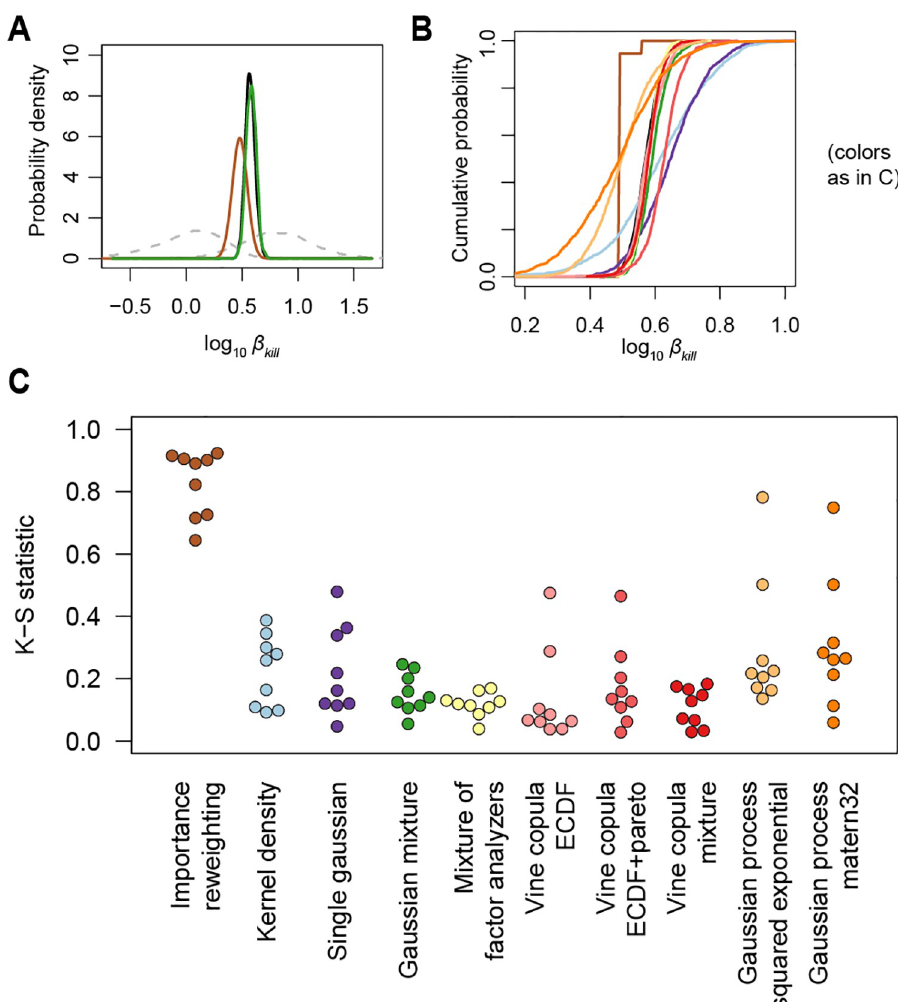
Fig 6. Sequential inference performance. (A) Marginal density of one of the parameters (for clarity, only the GM approximation and importance reweighting result is shown). The dashed lines indicate the posterior of the two datasets separately, and the black line is the true joint. Other colors are the same as in C. (B) Empirical cumulative distribution of the same parameter, showing all approximation methods. The colors are the same as in C. (C) Kolmogorov-Smirnov statistics for the comparison of the marginal distributions of the true joint to the marginals of the posterior obtained after sequential inference with each of the approximation methods. Each dot indicates one of the parameters.